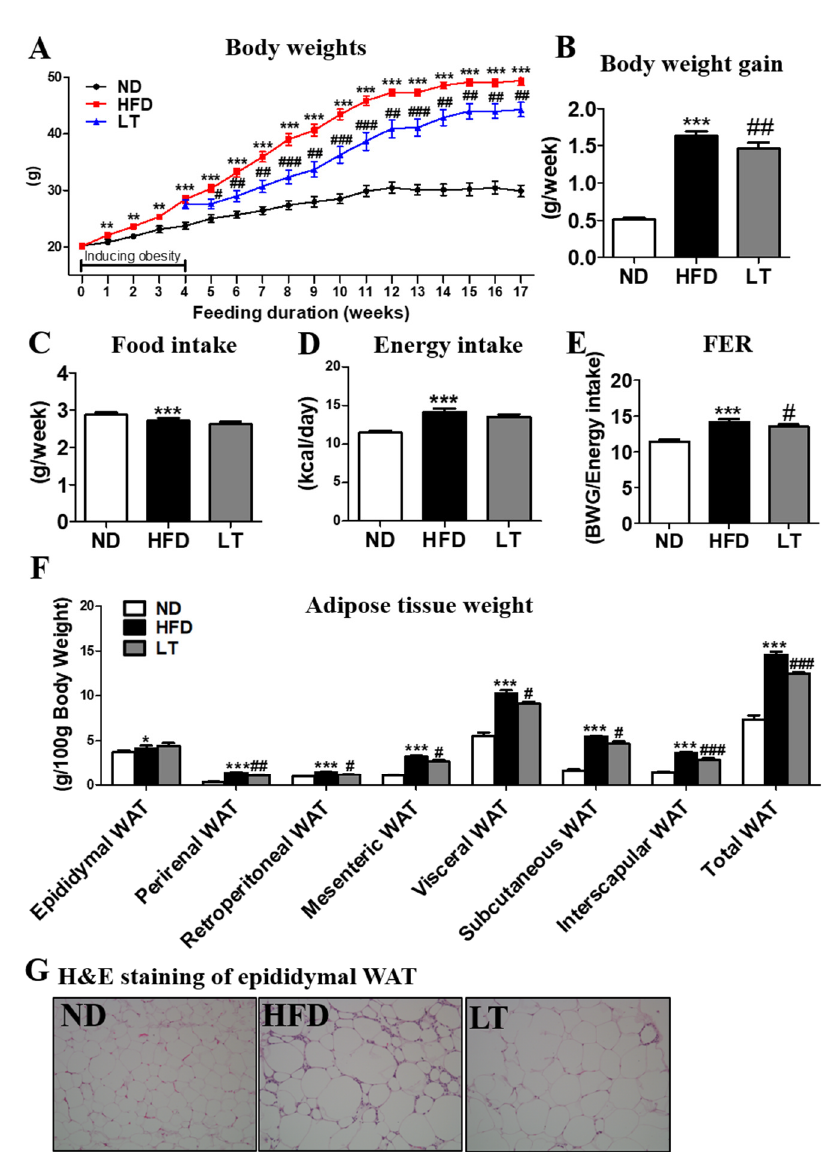
Figure 1. Effect of LT water extract supplement in diet-induced obesity on body weight ( A ), body weight gain ( B ), food intake ( C ), energy intake ( D ), food efficiency ratio ( E ), adipose tissue weight ( F ), adipose tissue morphology (200× magnification) ( G ); Data are the mean ± SE. Significant differences between HFD versus ND are indicated: * p < 0.05, ** p < 0.01, *** p < 0.001. Significant differences between HFD and LT are indicated: # p < 0.05, ## p < 0.01, ### p < 0.001. ND, normal diet (AIN-93G); HFD, high-fat diet (60% kcal from fat); LT, HFD + Lycopus lucidus Turcz water extract (1.5%, w / w ); FER, food efficiency ratio: body weight gain/energy intake per day; WAT, white adipose tis- sue.